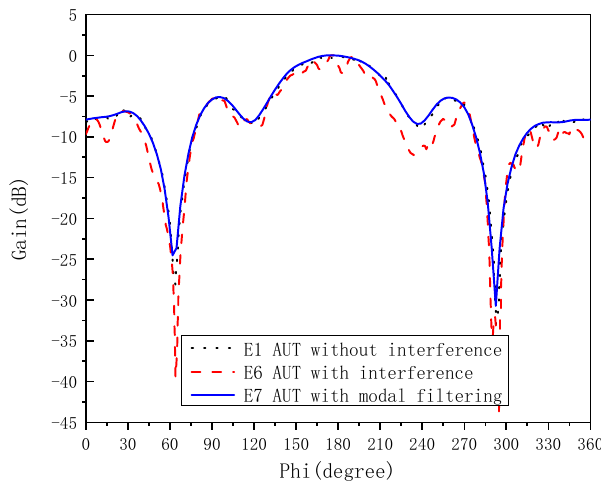
Figure 13. Comparison of the antenna pattern before filtering and after filtering.